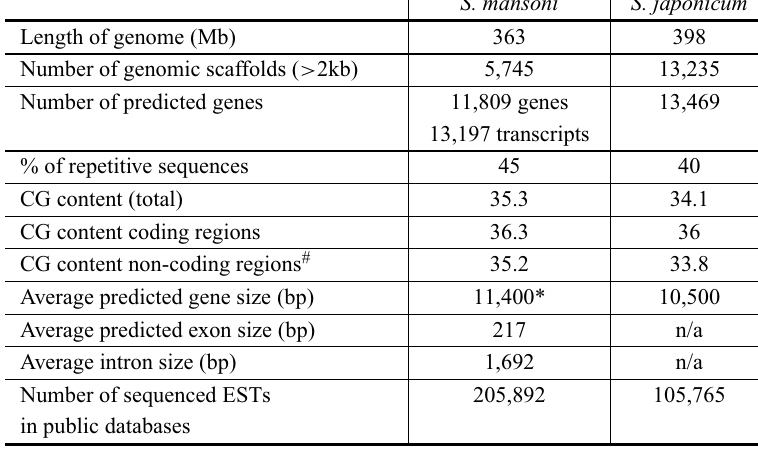
Comparison between S. mansoni and S. japonicum genomes and